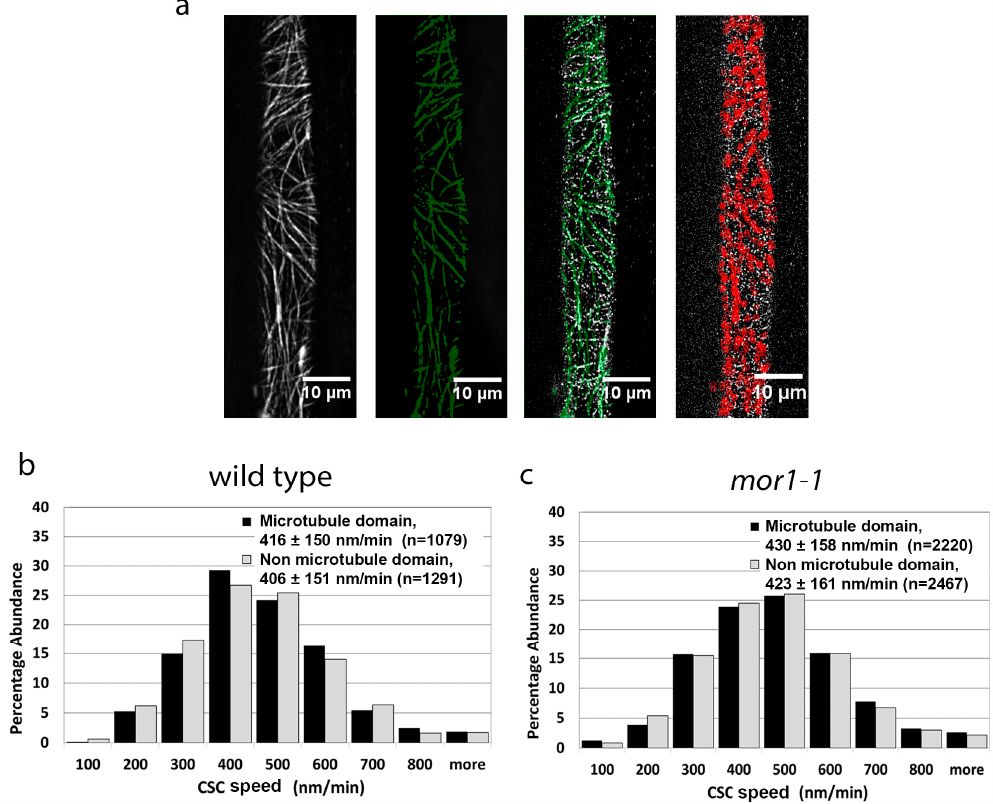
Figure 2. Cellulose synthase complex speed is not correlated with proximity to microtubules. ( a ) Particle tracking steps for CSCs in microtubule domains. Projections of 5-min time-lapse microtubule images (first panel) were used to define the microtubule domains by thresholding (green in second panel). The microtubule domain image was overlaid with CSC time-lapse images. The third panel is a single frame showing the overlay of microtubule domains (green) and YFP-CesA6 particles (white). Using spot detection plugins, CSCs were filtered from completely within the regions of interest, thus allowing the tracking of particles that remain completely within microtubule domains, as shown in the fourth panel as red. ( b , c ) Comparison of CSC velocity in microtubule domains versus non-microtubule domains in wild-type ( b ) and mor1-1 seedlings ( c ). Values are means ± SD. There was no significant difference in CSC velocity between microtubule and non-microtubule domains in both wild type and mor1-1 . Samples were incubated at 29 °C.